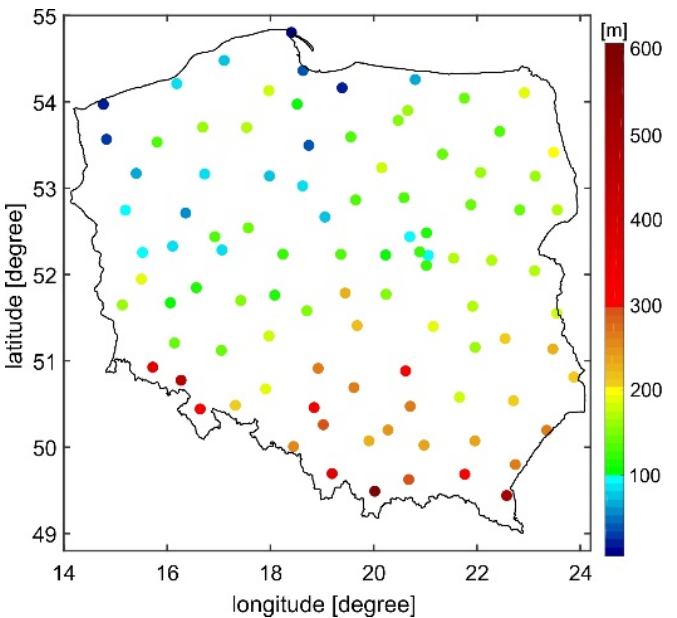
Figure 3. Orthometric/normal heights of ASG-EUPOS sites referred to the PL-EVRF2007-NH at the reference epoch 1 January 2008.